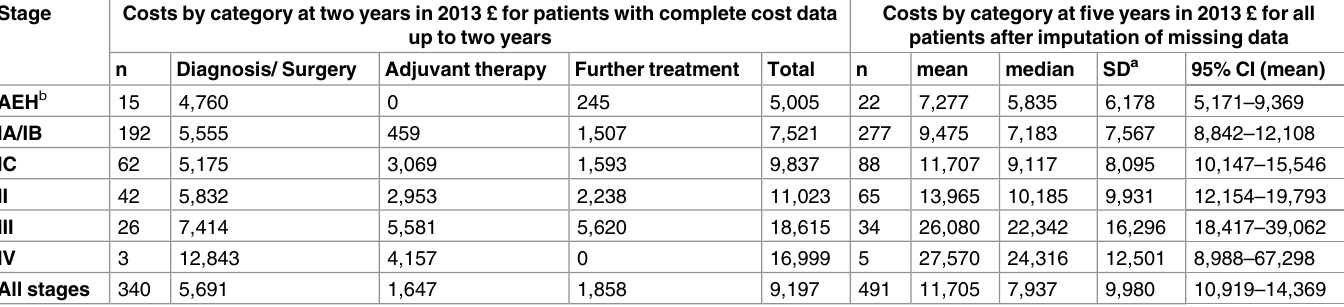
Table 2. Costs of treatment according to stage at two years post diagnosis for patients diagnosed prior to March 31 st 2008 and at five years for all patients after Multiple Imputation of missing data. Stage Costs by category at two years in 2013 £ for patients with complete cost data Costs by category at five years in 2013 £ for all up to two years patients after imputation of missing